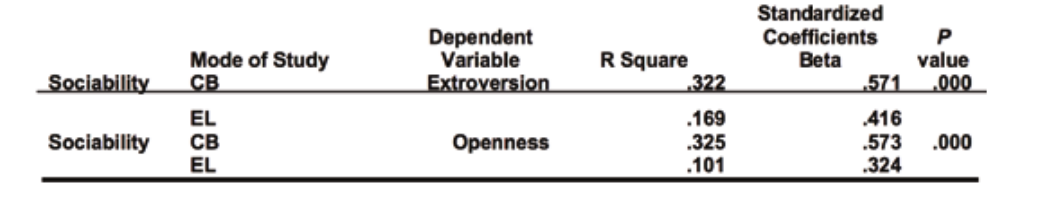
Table 9: Results of linear